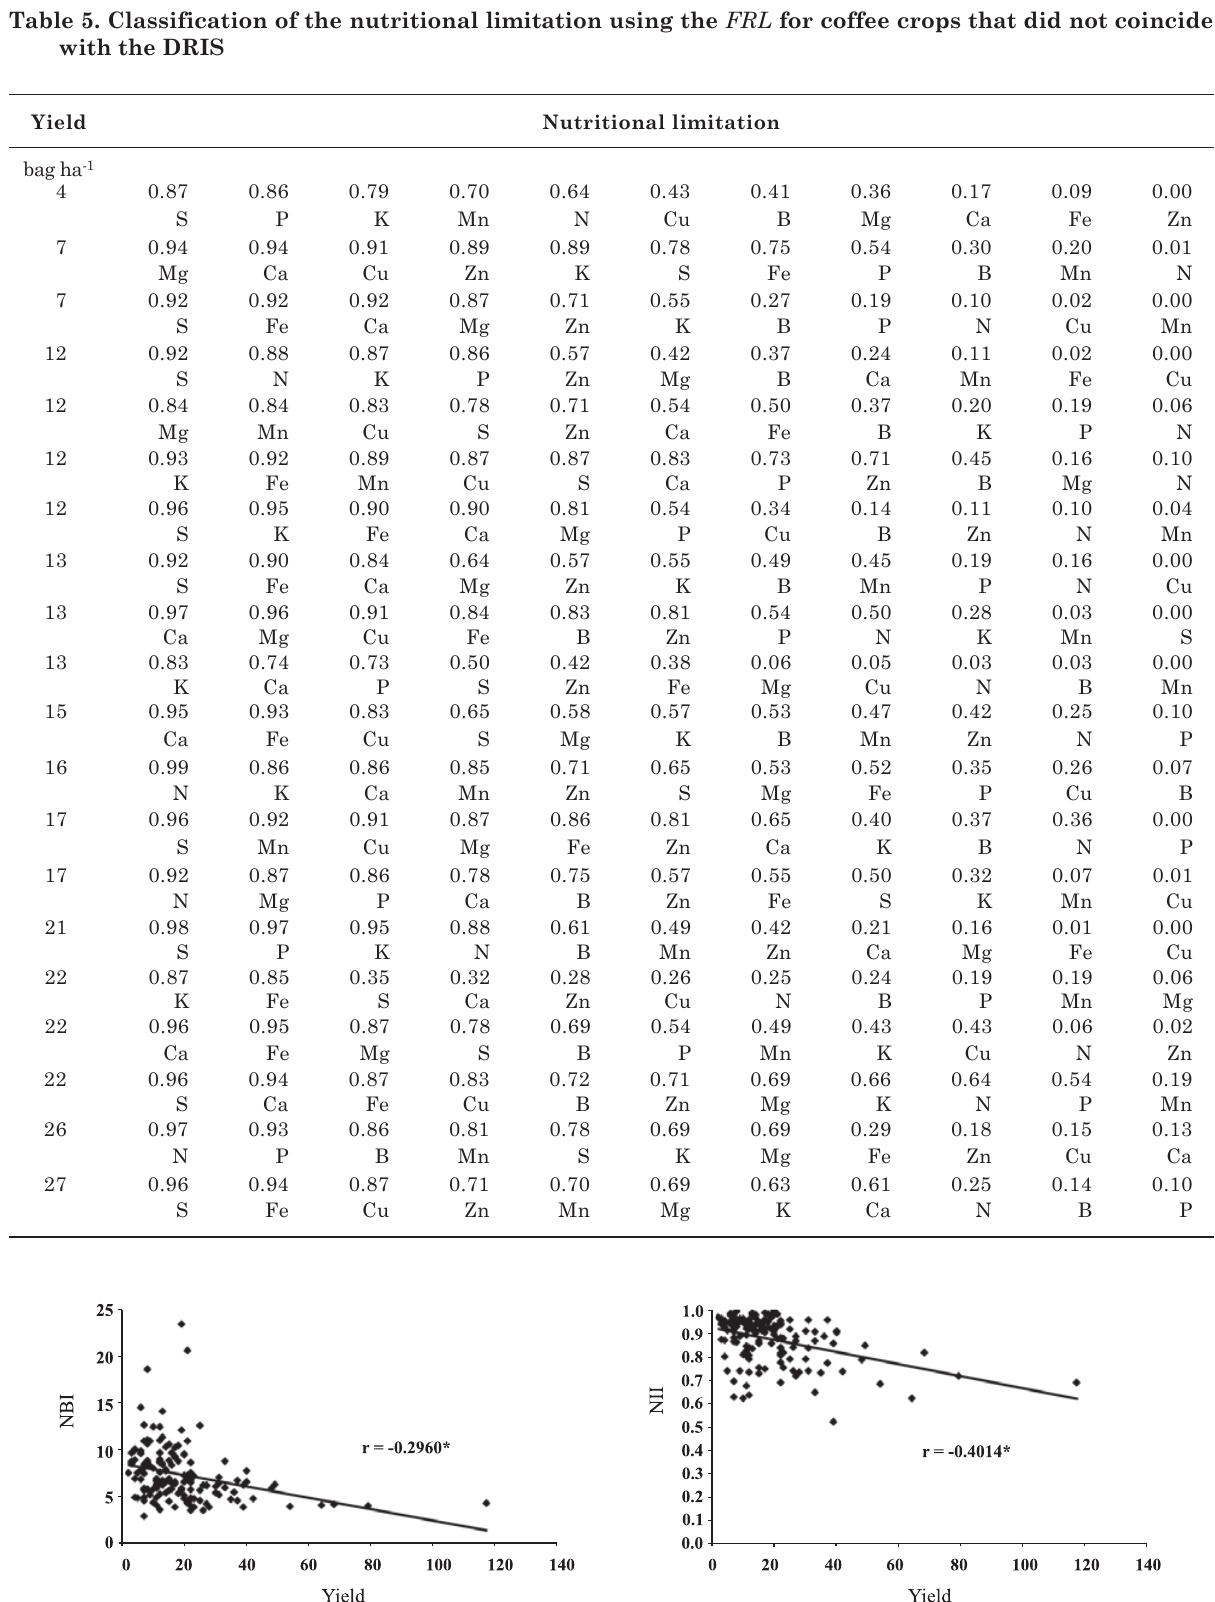
Figure 2. relationship between the nutritional Balance index (nBi) and the nutritional imbalance index (nii) with coffee